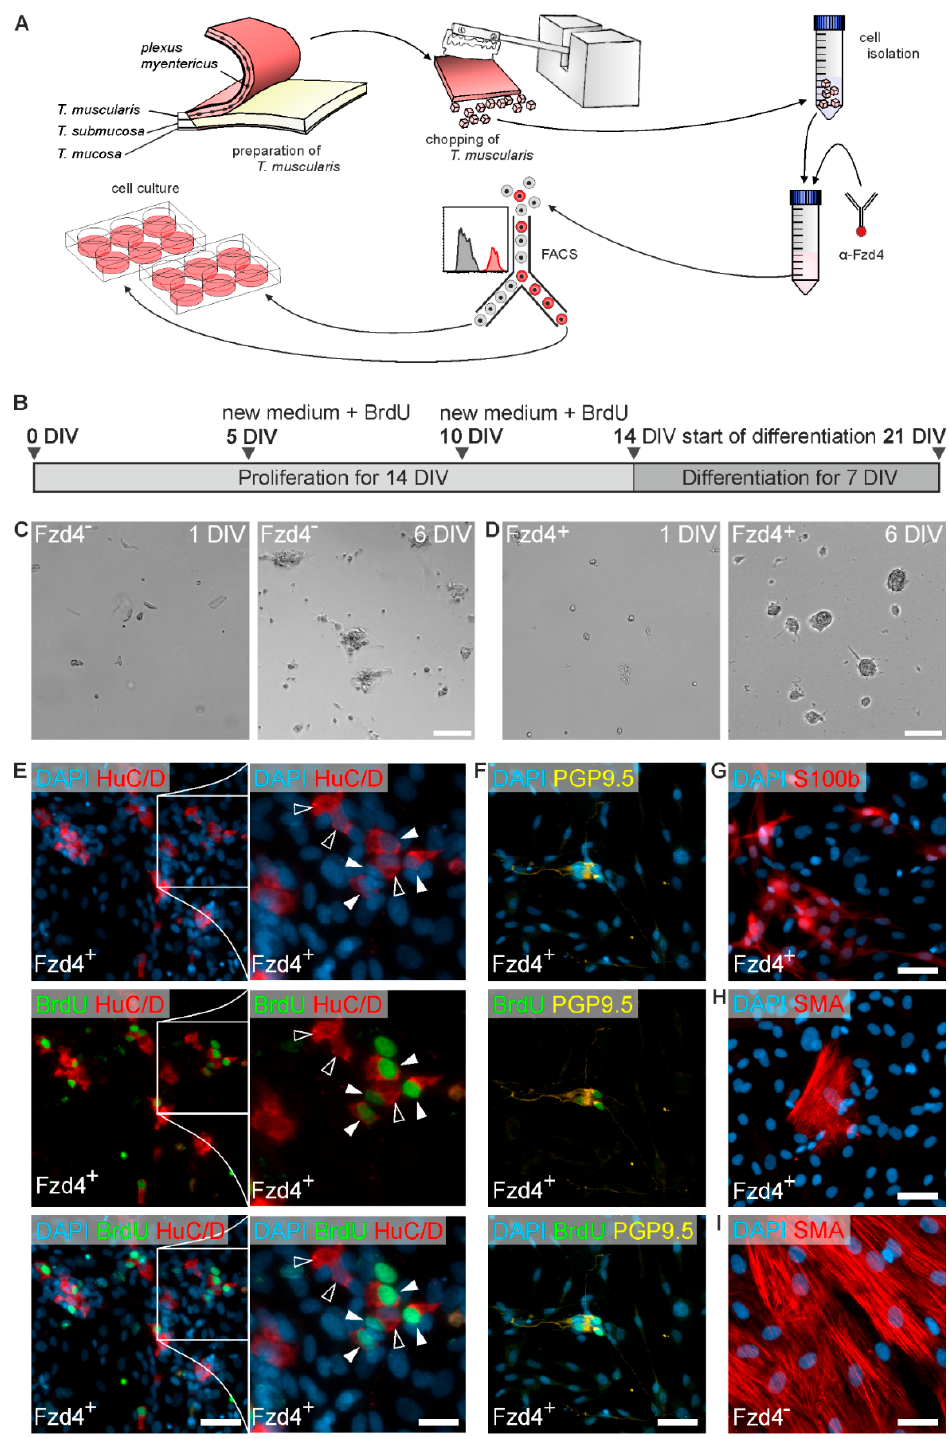
Figure 3. Neurosphere culture of Fzd4 + cells. ( A ) shows a scheme of the isolation and FACS procedures prior to culturing. Tunica muscularis of human resectates was detached from the other tissue layers and copped. Tissue parts were then digested with collagenase and dispase and isolated singe cells were stained with PE-conjugated anti-Fzd4 antibodies. FACS was used to separate Fzd4 + and Fzd4 − cell populations for subsequent culture. In ( B ) the timeline of the cell culture experiment is shown. Medium was replaced at 5 and 10 DIV (days in vitro) with BrdU being added on these days. After two weeks, we initiated cell differentiation. ( C ) and ( D ) show bright field micrographs of Fzd4 + and Fzd4 - cells during proliferation phase. Fzd4 + cells formed neurosphere-like bodies within 6 days in vitro , whereas most of the Fzd4 - cells largely grew adherent to the uncoated culture plastic. ( E–I ) depict immunostainings of the cell cultures after